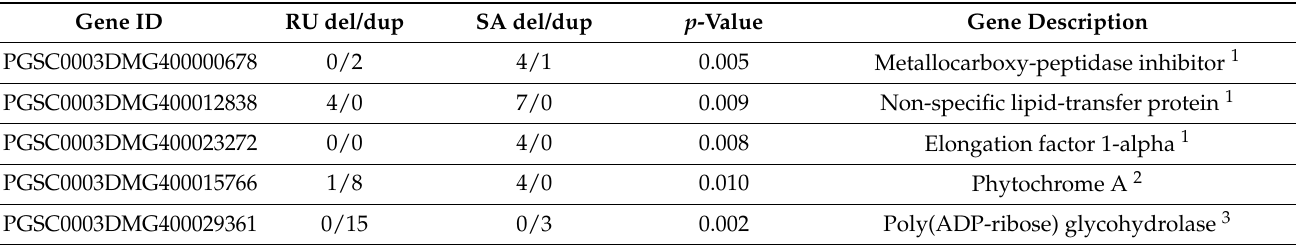
Table 5. The list of genes associated with tuberization and photoperiod control, for which CNV occurrence in genomes of Russian and South American accessions is significantly different. Gene IDs, number of significant CNV of deletion/duplication types in compared subsets, p -values (Fisher’s test), and gene description are